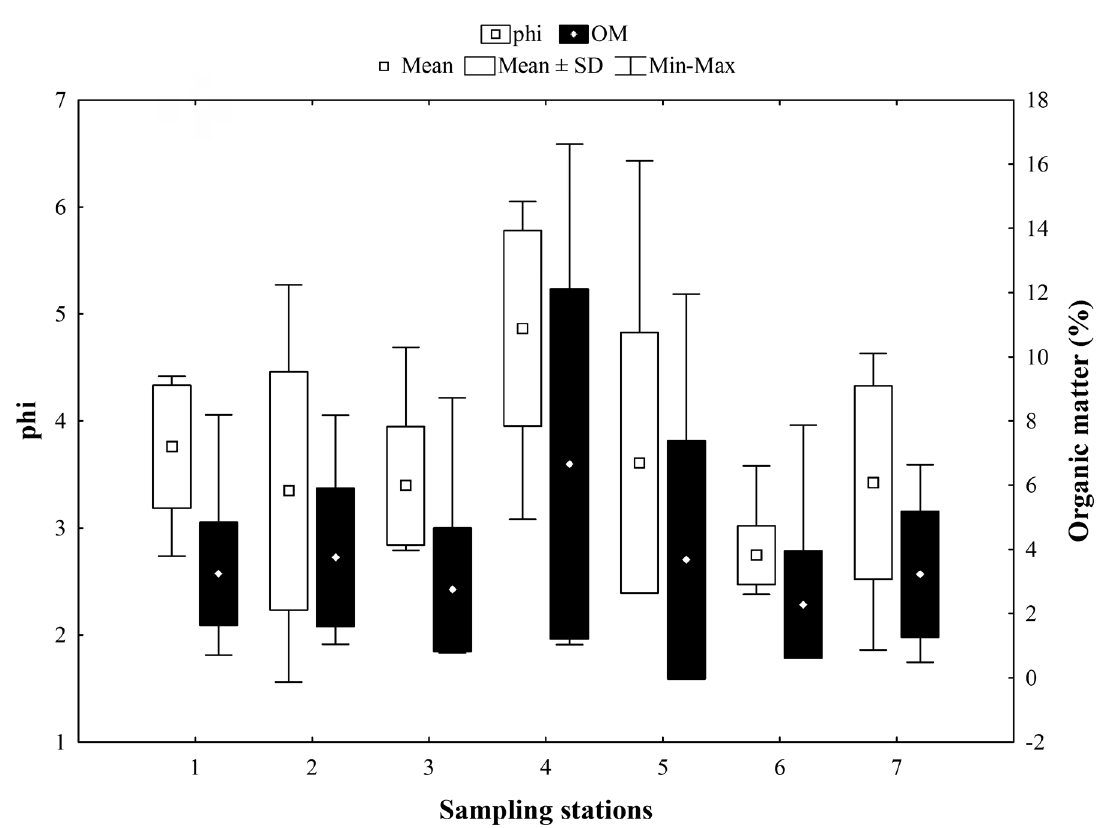
Figure 7. Spatial variation of organic matter (OM) and the sediment composition ( phi ) from July/2012 to June/2014, in Cananéia region, Brazil (Mean; SD = standard deviation; Min = minimum; Max =